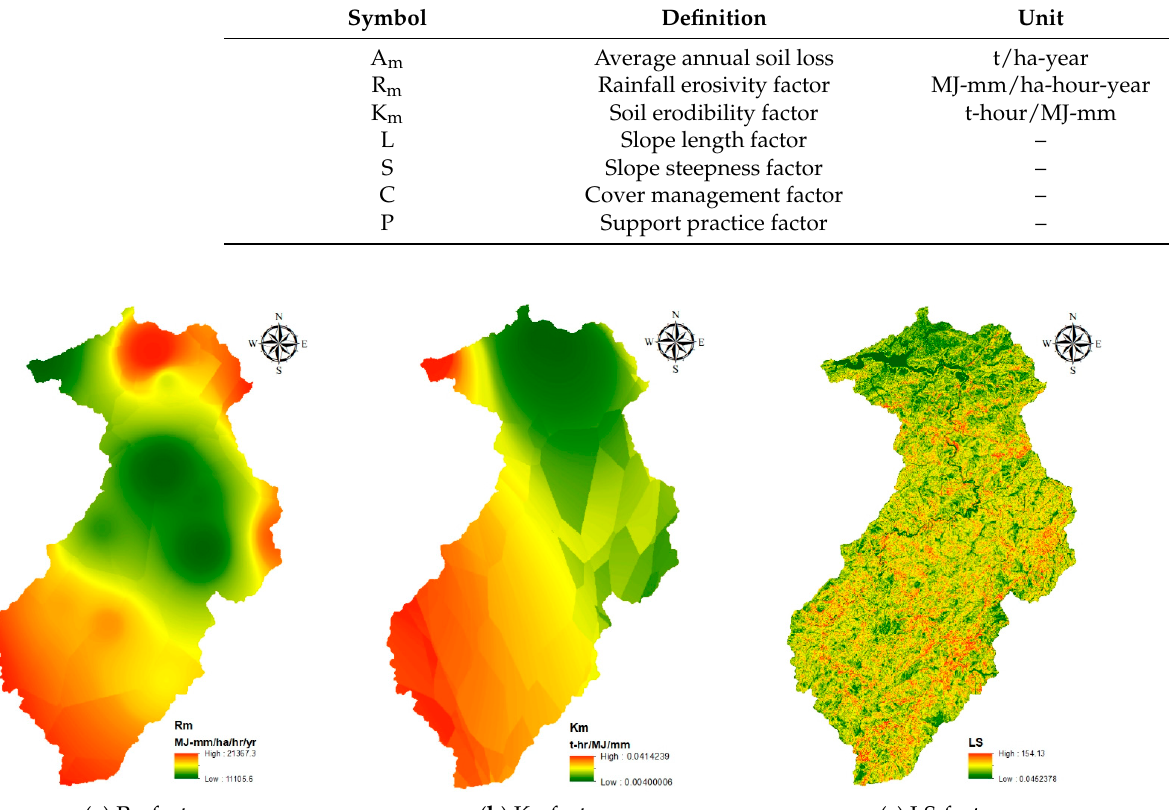
Table 6. The USLE factors and their definitions and units.